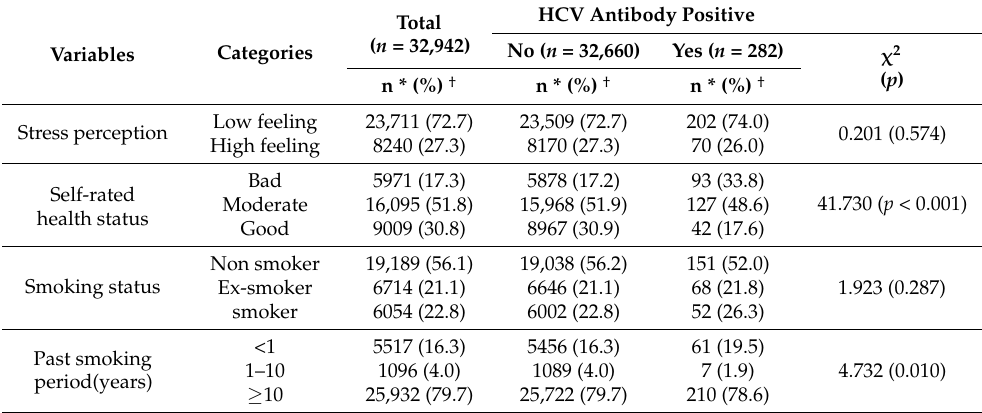
Table 2. Differences in HCV antibody status of Korean adults by health behavior and disease